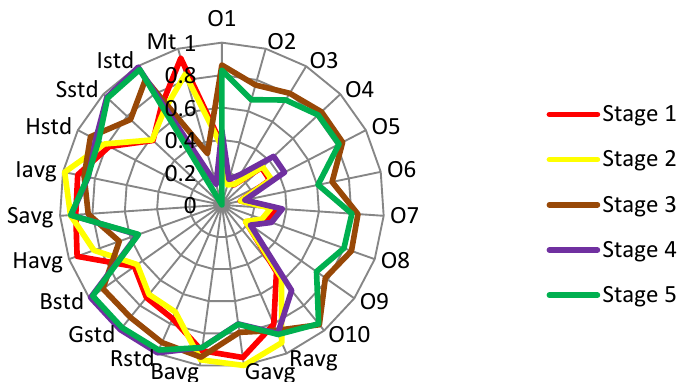
Figure 15. Radar chart of the odor, image, and moisture features in five stages.